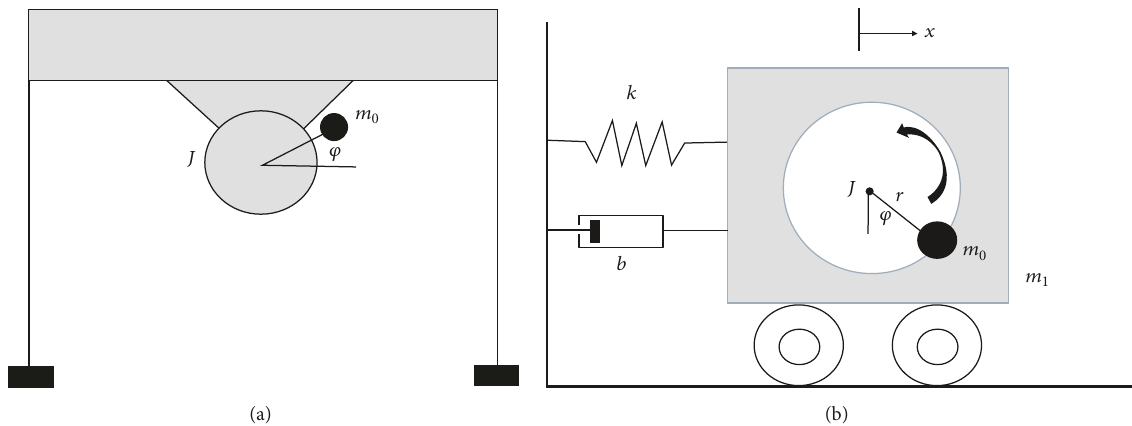
Figure 1: (a) Portal frame with nonideal excitation. (b) Coupled oscillator approximation.